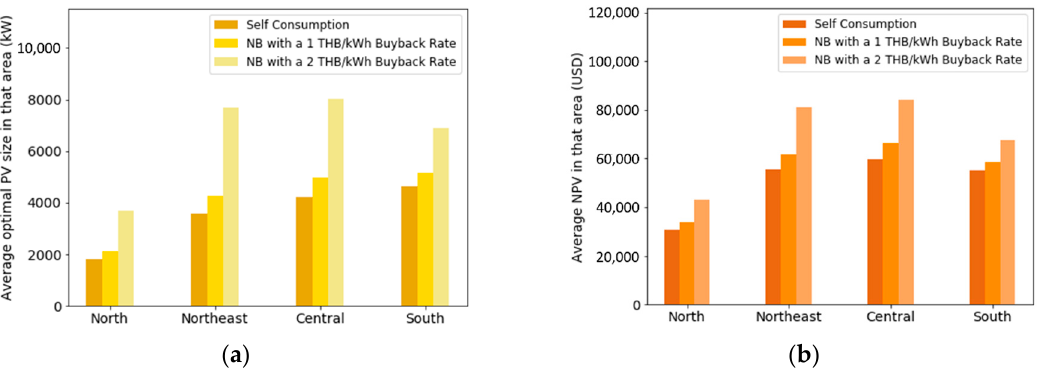
Figure 11. Comparison of ( a ) average optimal PV size and ( b ) NPV by region for LGS customers. (Note: The average optimal PV size and the average NPV are the average values among all provinces within a region).